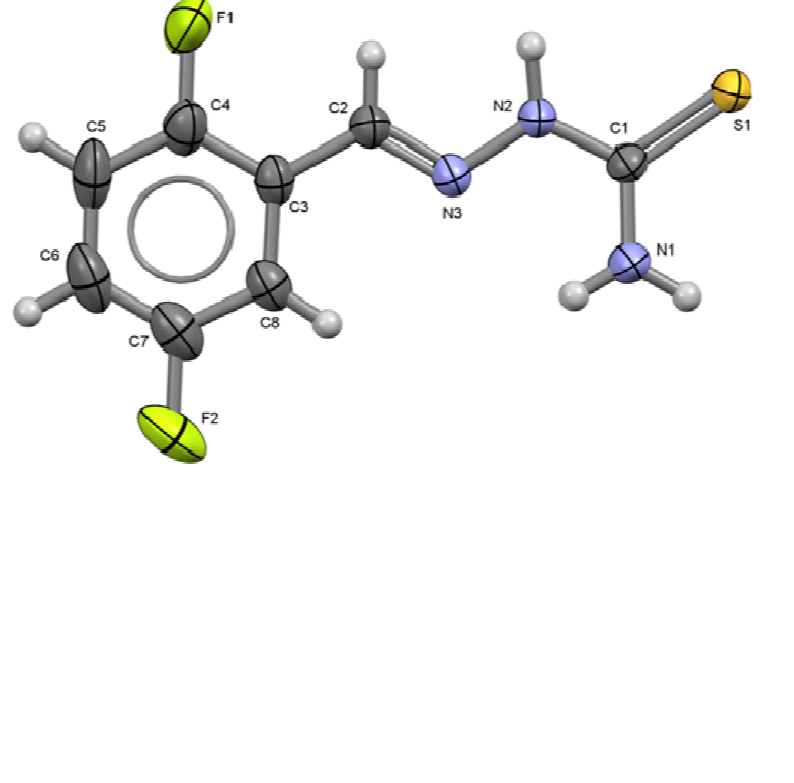
H F -CH=N-NH-C(S)NH ( 2 ). Thermal ellipsoids are 6 3 2 2